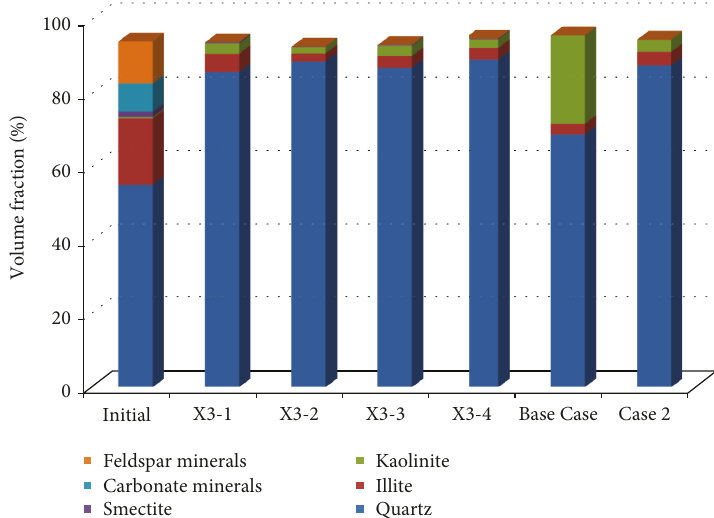
Figure 9: Comparison of the initial mineral assemblage of sandstone in the model, measured mineral assemblages of sandstone samples from Well X3 (X3-1, X3-2, X3-3, and X3-4), and simulated mineral assemblages of Base Case and Case 2 after 500,000 years. The simulation results show that the main brine-rock reactions induced by CO include the dissolution of feldspar minerals and carbonate minerals and the 2 precipitation of quartz and kaolinite. Table 5: List of kinetic rate parameters used in equations (A.1) and (A.2) for minerals considered in the simulations. Parameters for kinetic rate law of equations (A.1) and (A.2) Mineral A (cm 2 /g) Neutral mechanism